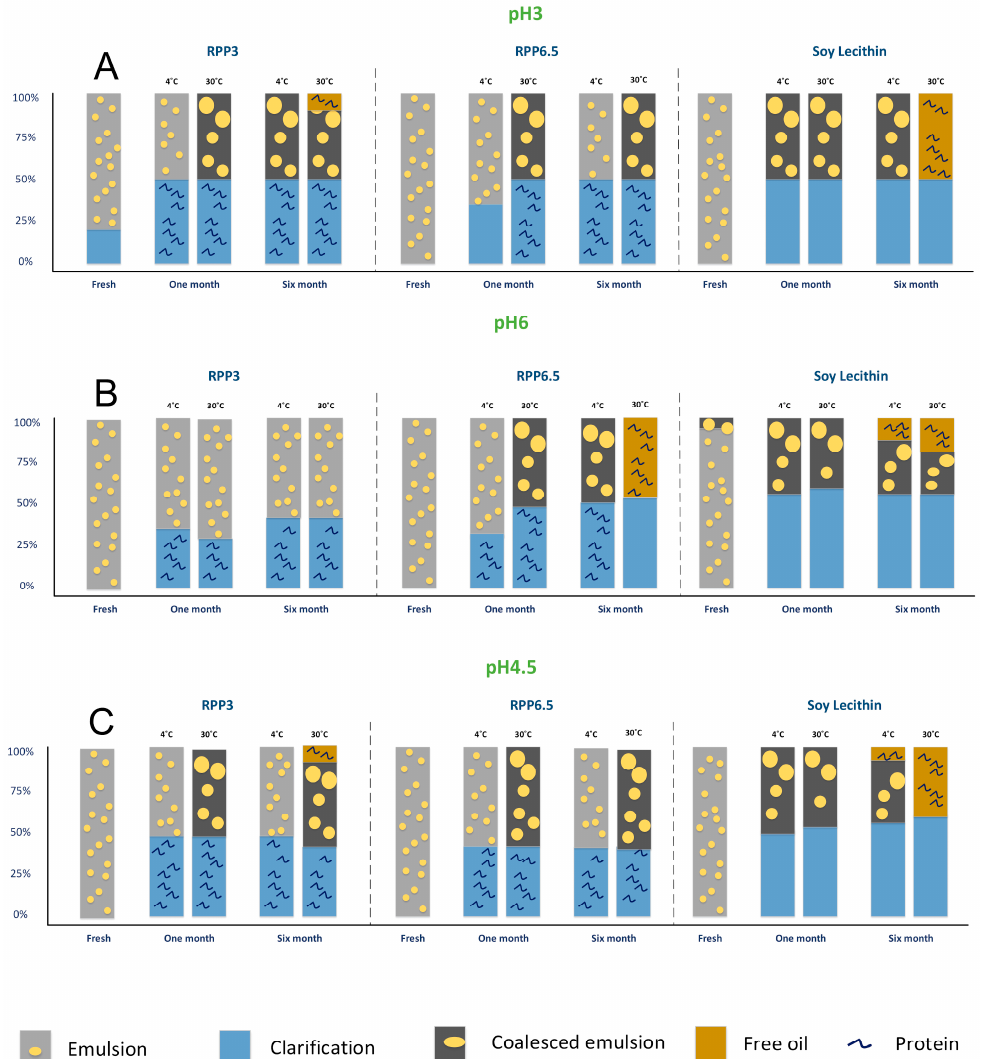
Figure 9. Schematic diagram of the phases observed for emulsions prepared with RPP3, RPP6.5 and soy lecithin after six months of storage at 4 and 30 ◦ C. ( A ) Emulsion pH 3, ( B ) Emulsion pH 6, ( C ) Emulsion pH